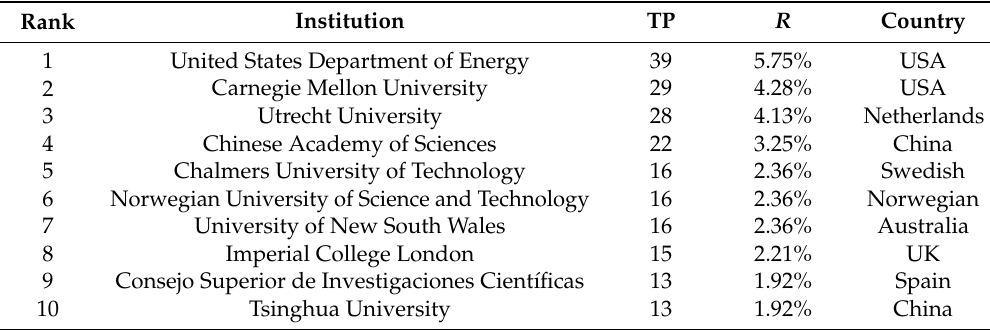
Table 3. High-yield institutions.